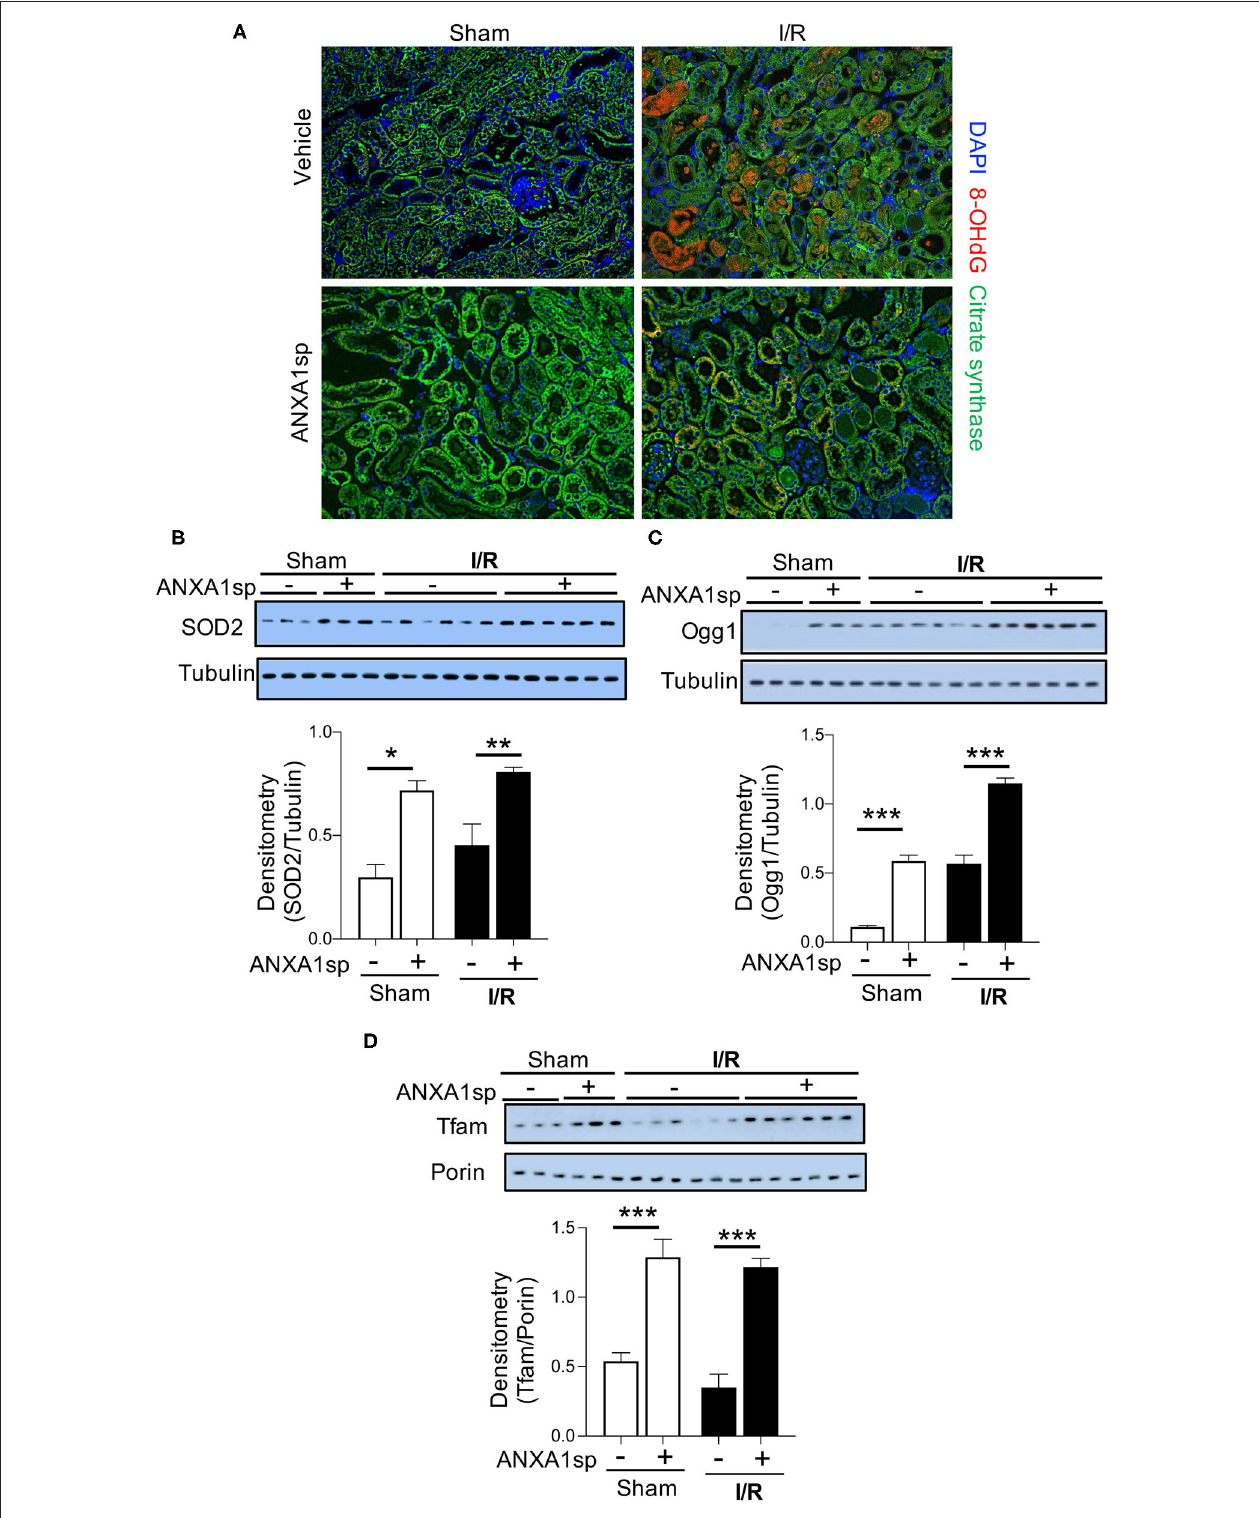
FIGURE 3 | ANXA1sp treatment limits oxidative damage and improves markers of mitochondrial integrity and function. Mice were treated with either Vehicle or ANXA1sp 1h prior to ischemia, subjected to 33min of unilateral ischemia and contralateral nephrectomy, and then re-injected with Vehicle or ANXA1sp 1h